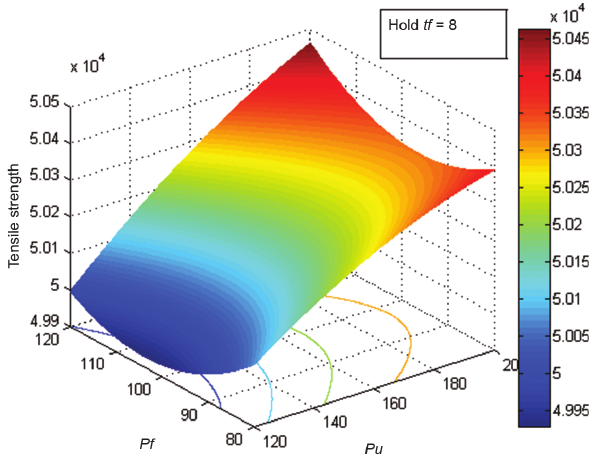
Figure 6: Surface plot of tensile strength versus Pf and Pu .